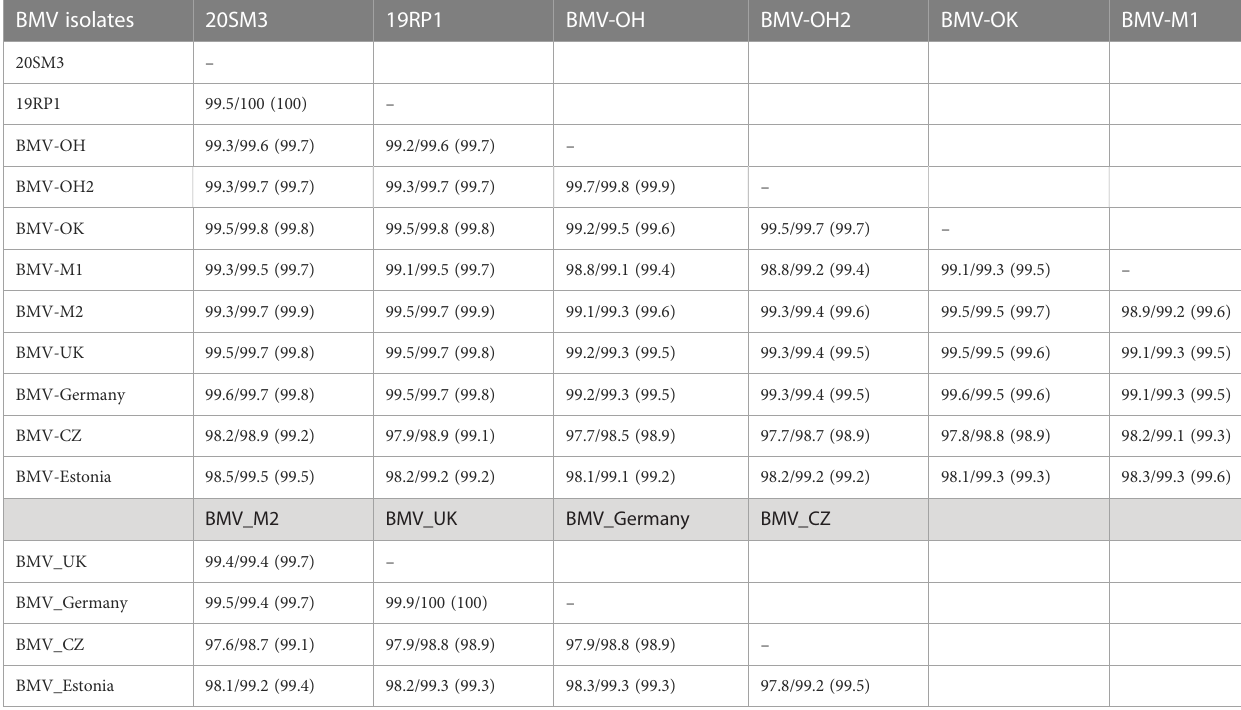
TABLE 1 Nucleotides/amino acid sequence identity (similarity) of RNA1/RNA1a genome of rome mosaic virus (BMV) isolates from Kansas and other known BMV isolates retrieved from GeneBank.